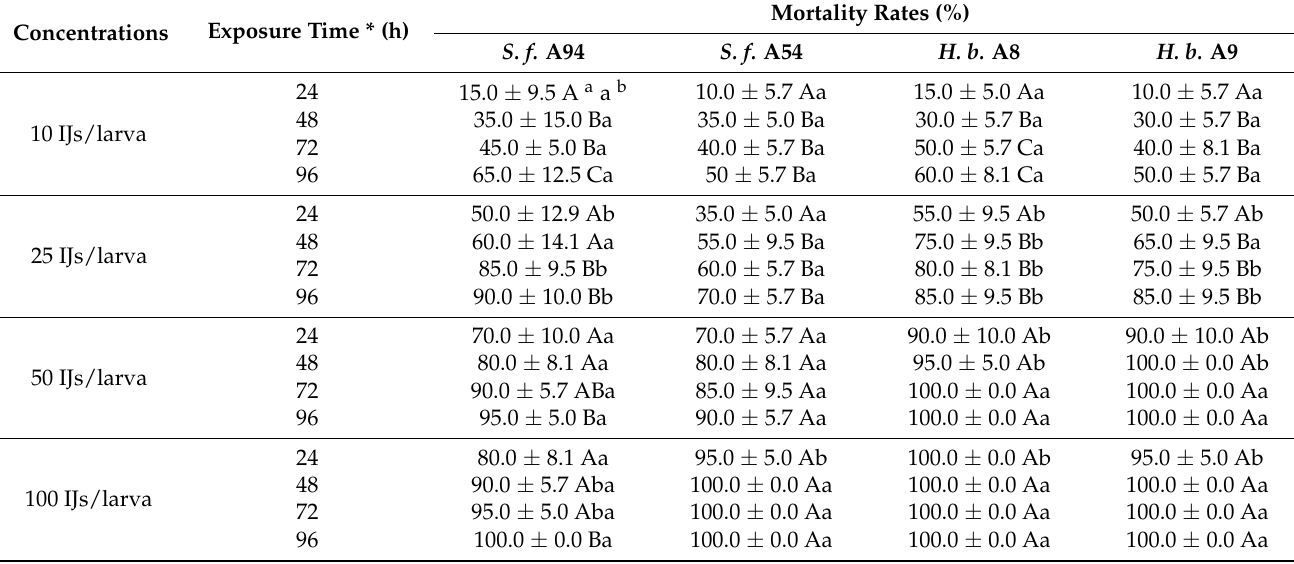
Table 6. The efficacy of the selected EPN species/isolates on the 5th instar larvae of C. pomonella (25 ◦ C, 60%